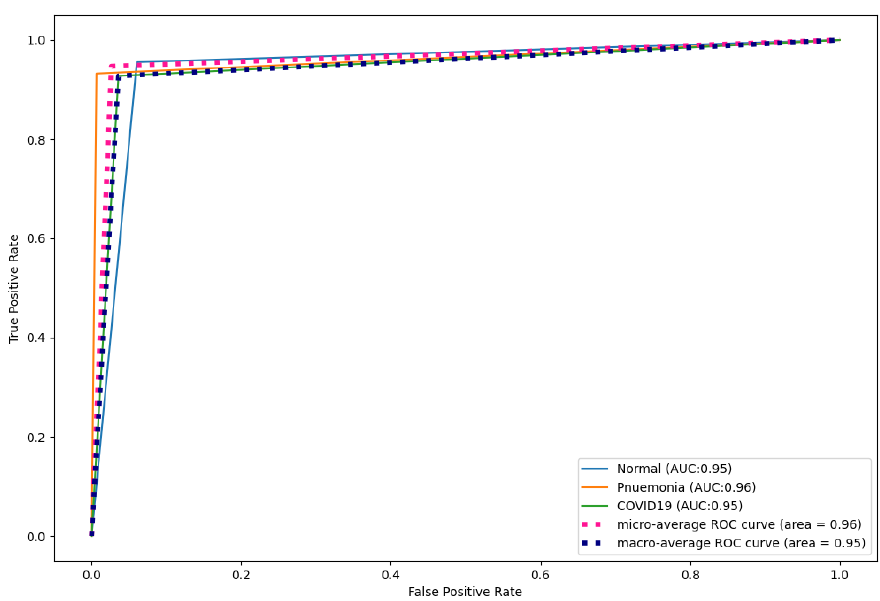
Figure 13. CapsNet ROC curves for X-ray images.